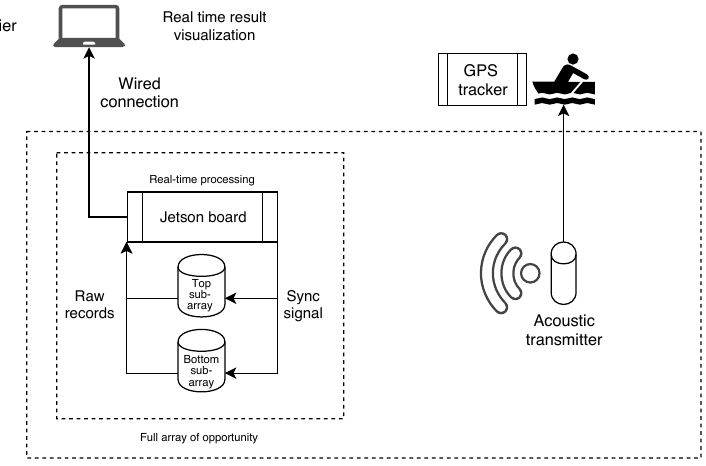
Figure 7. Conceptual organization of the